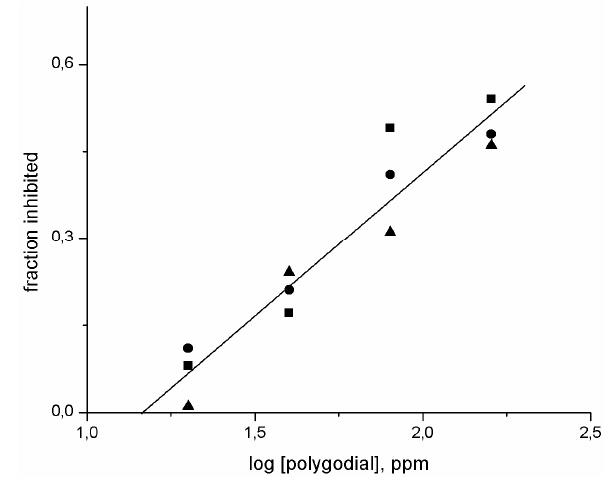
Figure 9. Fraction of inhibited mycelial growth as a function of polygodial concentration: ( ■ ) B05.10; ( ● ) PN2; ( ▲ ) 7AC.